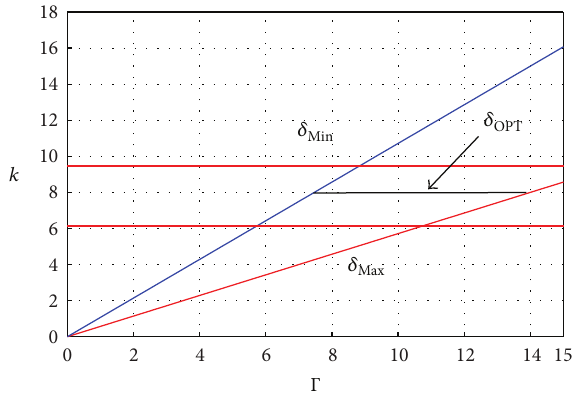
Figure 3: Range of the solutions in boost